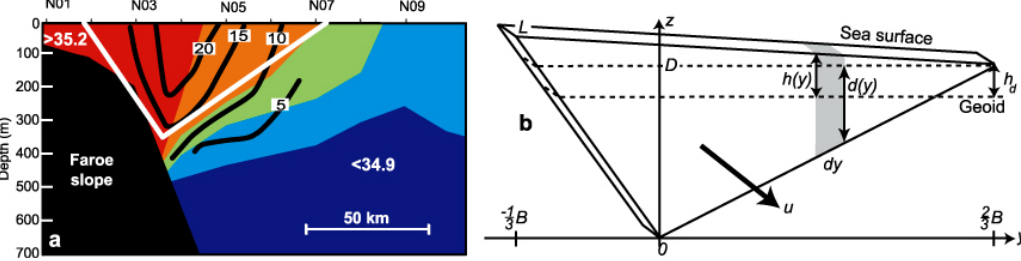
Fig. 8. Model geometry and notation. (a) The white lines indicate the triangular model geometry superposed on the typical salinity (back- ground colours, based on Fig. 2b) and eastward velocity (based on Hansen et al., 2003) distributions. (b) A slice of Atlantic water in the model of thickness L ( D = 350m, B = 100km).